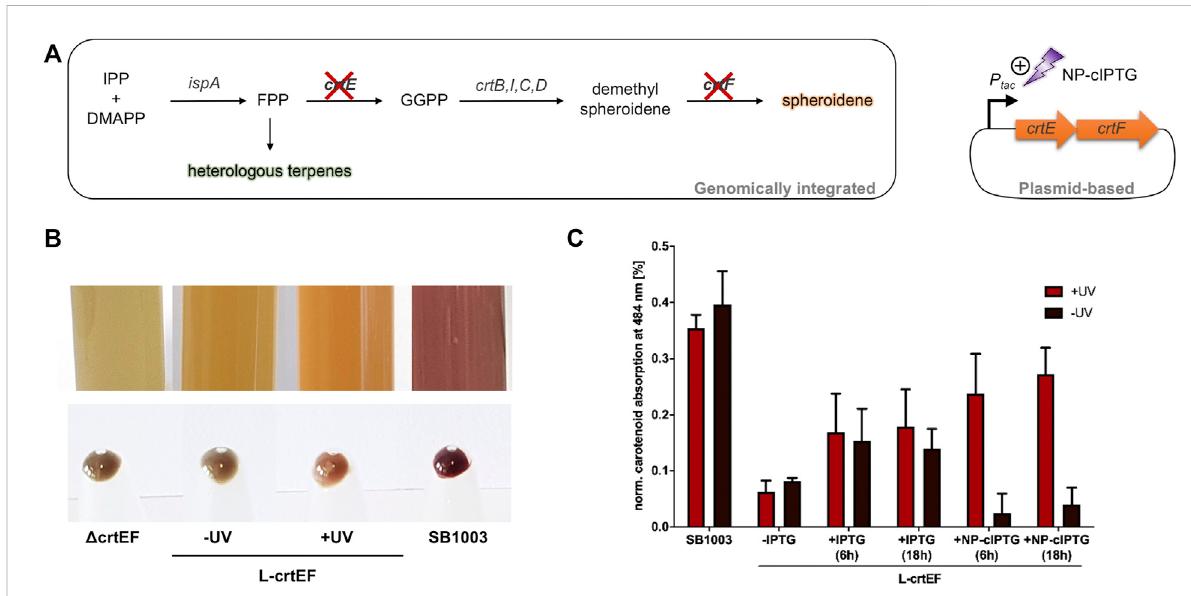
FIGURE 5 Light-controlled induction of carotenoid production in phototrophically grown R. capsulatus SB1003 Δ crtEF cells carrying pRholtHi-crtE-crtF. (A) Intrinsic carotenoid synthesis of R. capsulatus starting from the terpene C 5 building blocks IPP and DMAPP. Deletion of genes encoding the relevant carotenoid pathway enzymes CrtE and CrtF results in a carotenoid-de fi cient strain (Hage-Hülsmann et al., 2019). The genes crtE and crtF were cloned in a plasmid and placed under control of the P tac promoter to facilitate IPTG-based control. Light-mediated induction of crt gene expression was achieved by using NP-cIPTG. IPP, isopentenyl pyrophosphate; DMAPP, dimethylallyl pyrophosphate; FPP, farnesyl pyrophosphate; IspA, FPP synthase; GGPP, geranylgeranyl pyrophosphate; CrtE, GGPP synthase; CrtB, phytoene synthase; CrtI, phytoene desaturase; CrtC, hydroxyneurosporene synthase; CrtD, hydroxyneurosporene desaturase; CrtF, demethylspheroidene O-methyltransferase. (B) Pigmentation of phototrophically grown R. capsulatus strains SB1003 Δ crtEF ( Δ crtEF), SB1003 Δ crtEF /pRholtHi-crtE-crtF supplemented with 1 m M NP-cIPTG under non-illuminated(-UV,L-crtEF)orUV-Ailluminatedconditions(+UV,L-crtEF)andSB1003wildtypestrain(SB1003).Besidesliquidcultures,cellpellets corresponding to an optical density at 660 nm of 2.5 are shown. (C) Carotenoid absorption at 484 nm of R. capsulatus SB1003 Δ crtEF /pRholtHi- crtE-crtF(L-crtEF)culturessupplementedwith1 m M NP-cIPTG(+NP-cIPTG +UVand-UV)areshownincomparisontotherespectiveabsorptionof extracts from R. capsulatus SB1003 wildtype (SB1003) cells. In addition, cell cultures supplemented with 1 m M IPTG (positive control, +IPTG) or without IPTG (negative control, -IPTG) were likewise analyzed after 48 h of phototrophic cultivation [RCV medium, 30 ° C, screw neck vials, NIR light ( λ max = 850 nm, 1.7 mW/cm 2 )]. R. capsulatus SB1003 Δ crtEF cultures were used to determine the background absorption at 484 nm and thus correspondingvaluesweresubtractedfromallothervalues.Induction wasperformedafteracultivationtimeofsixor18 h via